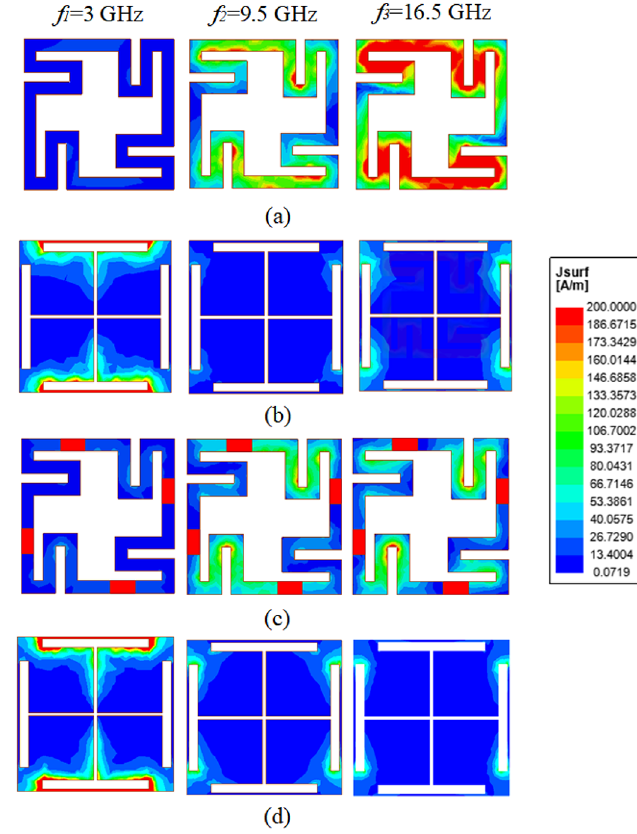
Fig. 3. The surface current distribution of the lossy layer and lossless layer with R and without R at f 1 = 3GHz, f 2 = 9.5GHz, f 3 =16.5 GHz, respectively. (a) Current distribution of lossy layer without R. (b) Current distribution of lossless layer without